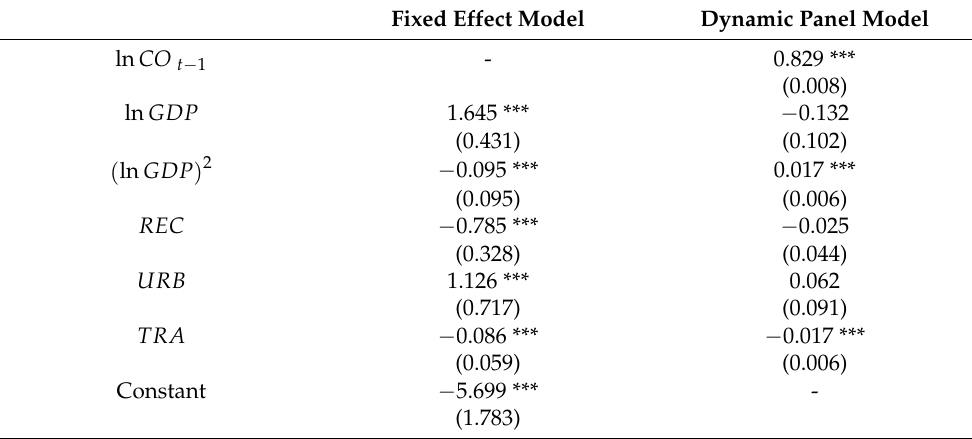
Table 5. Estimation Results for Carbon Monoxide Emissions